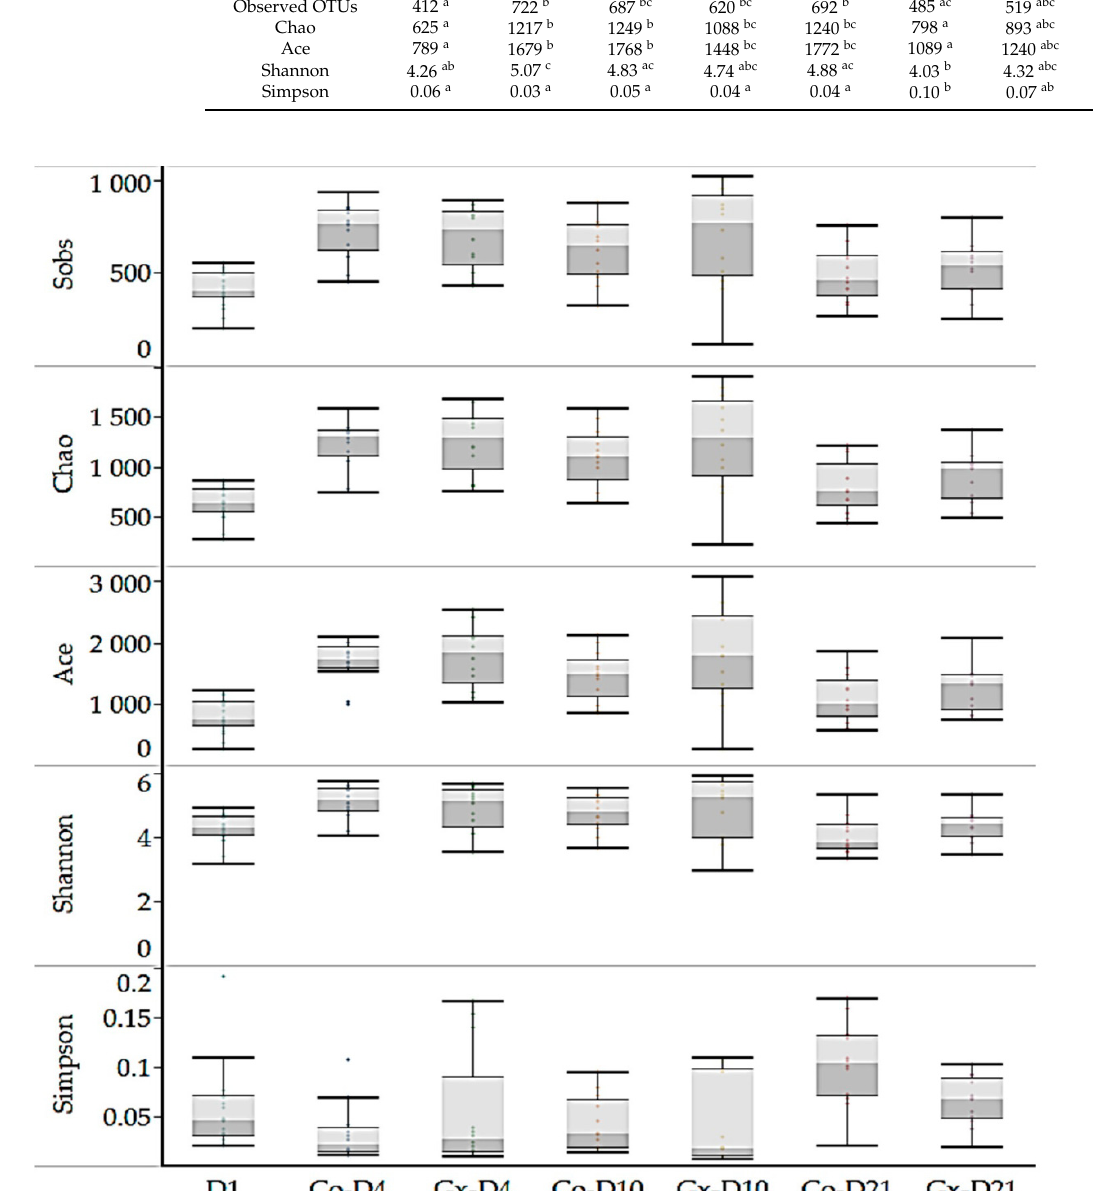
Figure 2. Box plot diagram showing the distribution of alpha diversity indices across the supplemented (Gx) or non- supplemented (Co) groups investigated in this study.